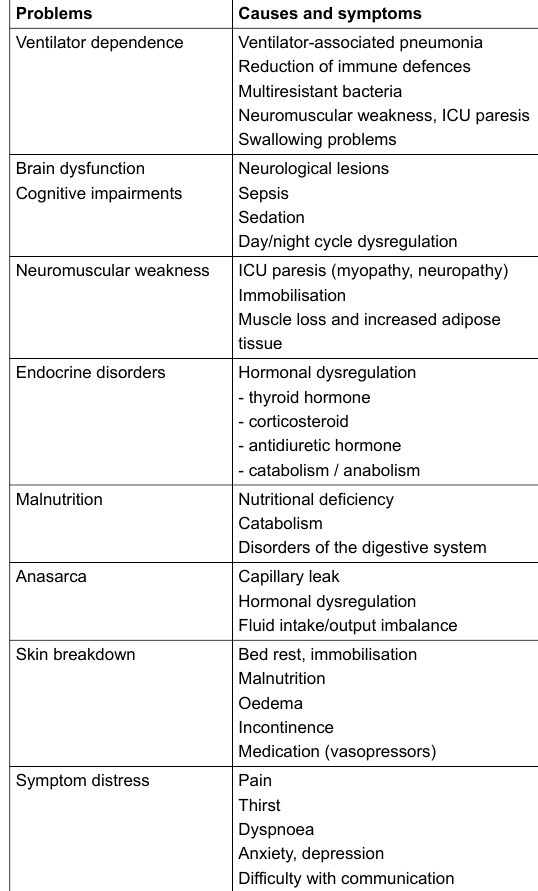
Table 1: Specific problems of prolonged-stay patients in the intensive care unit (ICU), derived from Nelson et al. [3] .